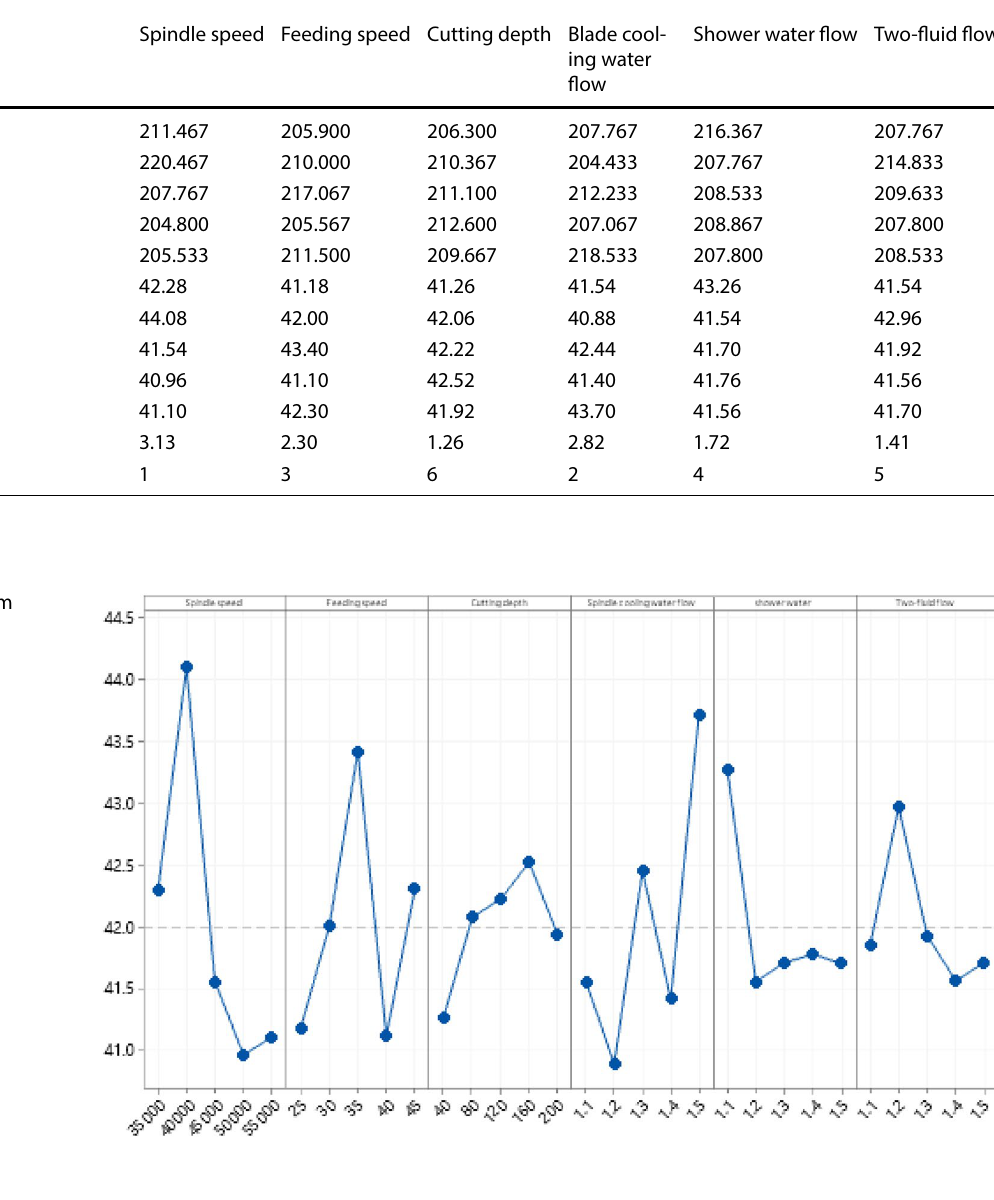
Table 4 Analytical results of the orthogonal experimental The order of the total value, mean and extreme deviation of the level of